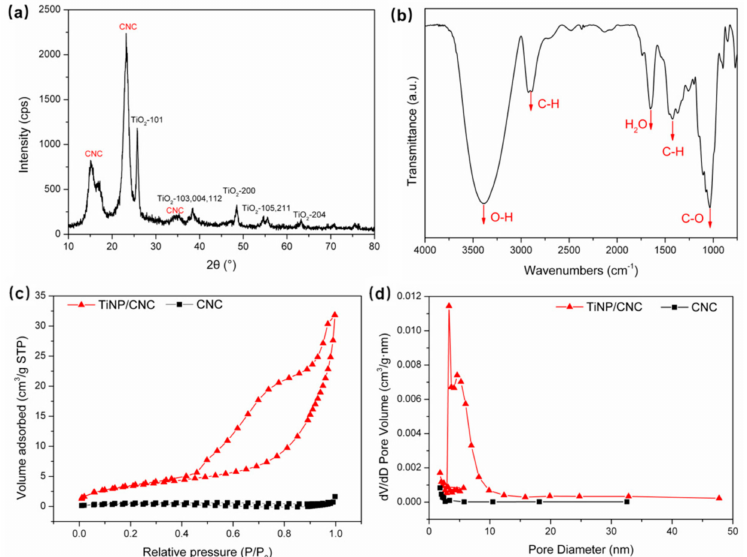
Figure 3. ( a ) X-ray diffraction pattern, ( b ) Fourier transform infrared spectroscopy spectrum, ( c ) nitrogen adsorption–desorption isotherms and ( d ) pore size distribution of 6% TiNP/CNC composite